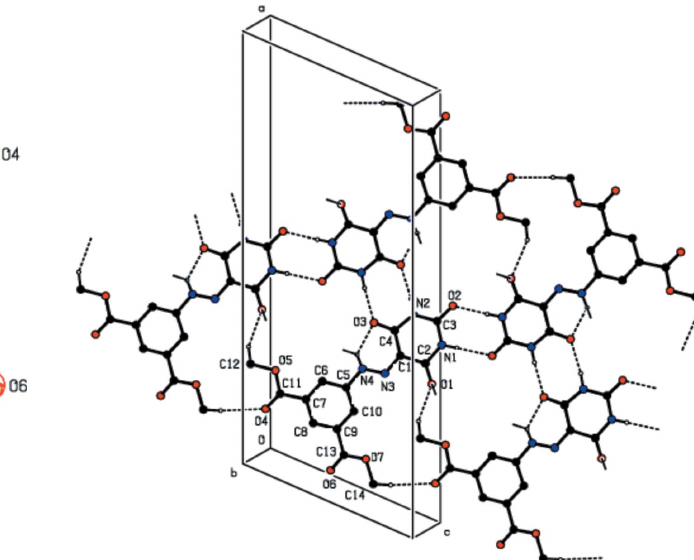
Figure 3 A view of intermolecular hydrogen bonds forming the ribbons along the c -axis